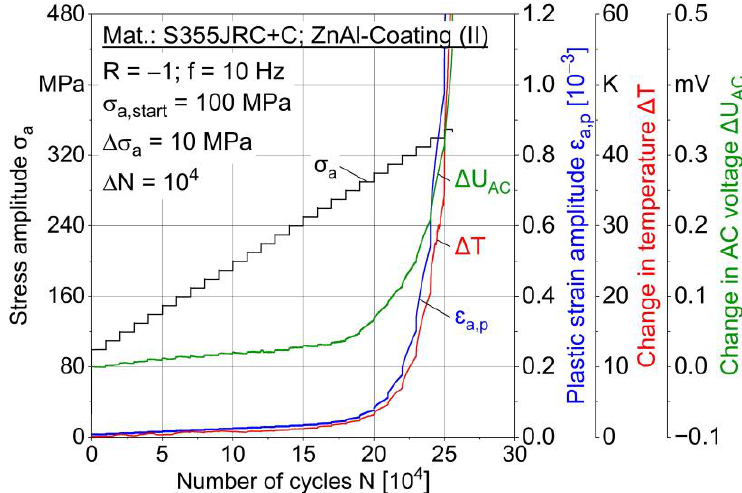
Figure 12. Multiple amplitude test (MAT) for ZnAl-coated (II) specimen.